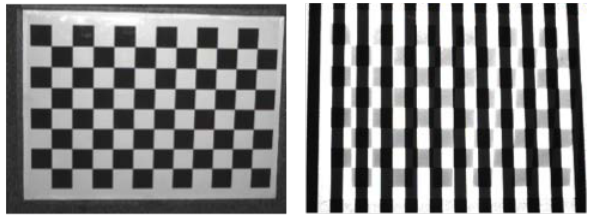
Figure 2: Example calibration images: the checkerboard used in the process (left) and the captured image which is projected by one of the gray code (right).